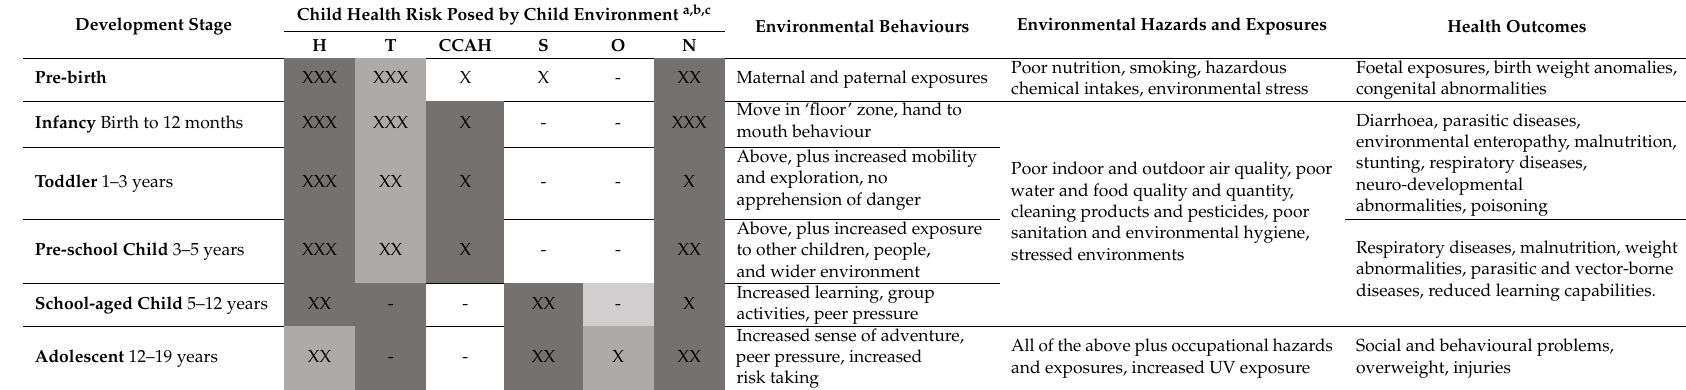
Table 1. Childhood environmental health risks by development stage.